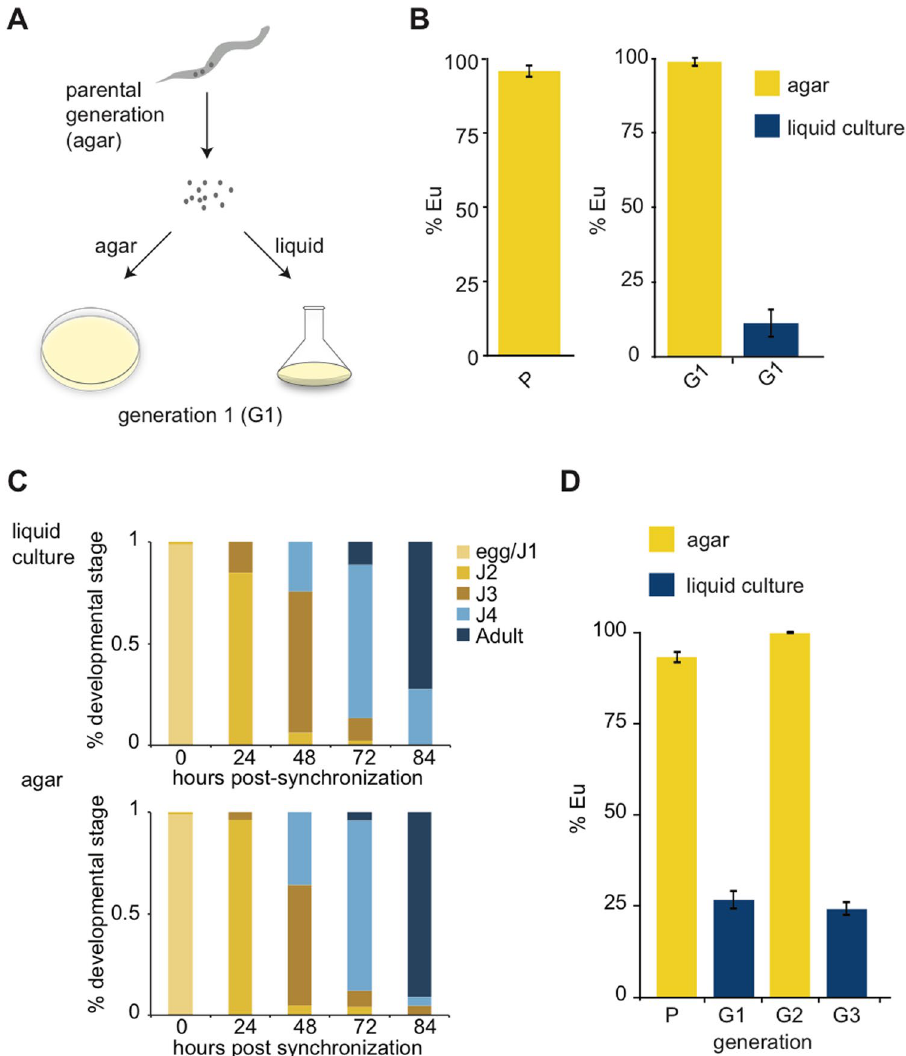
Figure 2. Different culture methods affect mouth-form phenotypic plasticity. ( A ) Diagram of experimental design to compare culture conditions from the same population after bleach synchronization. ( B ) Mouth-form ratios presented as percent eurystomatous (% Eu) from the parental generation (P) and the next generation (G1) grown in either liquid culture or agar plates, n = 18 biological replicates, p < 0.05, students two-tailed t-test , error bars represent SEM. ( C ) Developmental stages of bleach-synchronized P . pacificus in either agar plates or liquid culture. Bar graphs represent a typical experiment measuring > 30 animals at the indicated time-points. ( D ) Mouth-form ratios of switching experiments between agar and liquid cultures. Nematodes were bleached between generations (P, G1, G2), and eggs-J1 larvae were passed to the next condition, n = 3, error bars represent